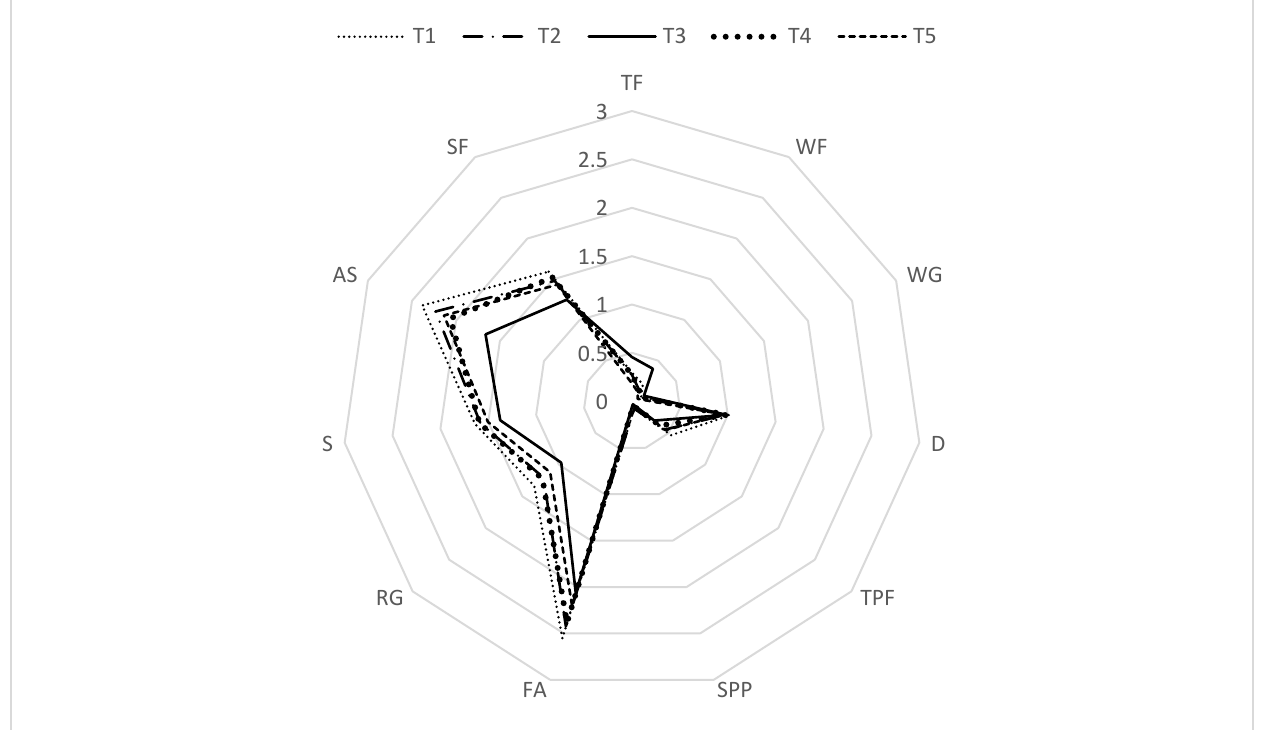
Figure 4. Graphic for the HEI components consumed among moments. Each angle of the graphic represents a distinct component (i.e., TF — Total Fruits, WF — Whole Fruits, WG — Whole Grains, D — Dairy, TPF — Total Protein Foods, SPP — Seafood and Plant Protein, FA — Fatty Acids, RG — Refined Grains, S — Sodium, AS — Added Sugars, SF — Saturated Fats), and a distinct line represents each moment. Unity of measures = portions.